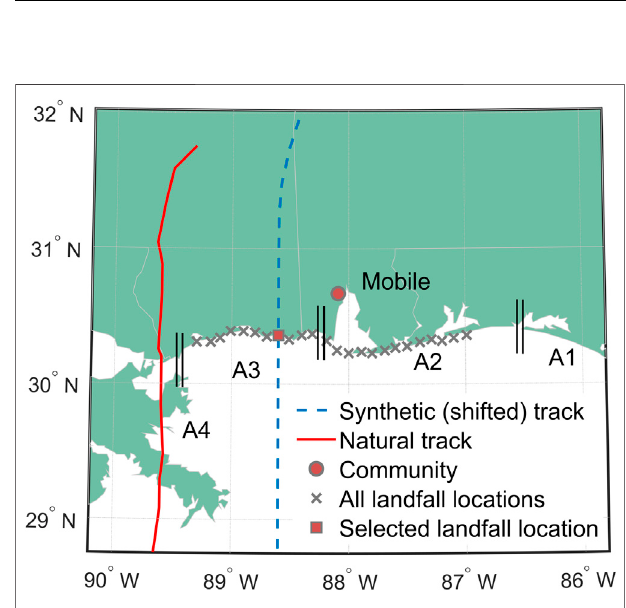
FIGURE 10 | Comparison of water level from observation stations (red dashed lines) and model simulation (gray lines) for baseline scenario at (A) Dauphin island and (B) Pensacola, FL observation stations.